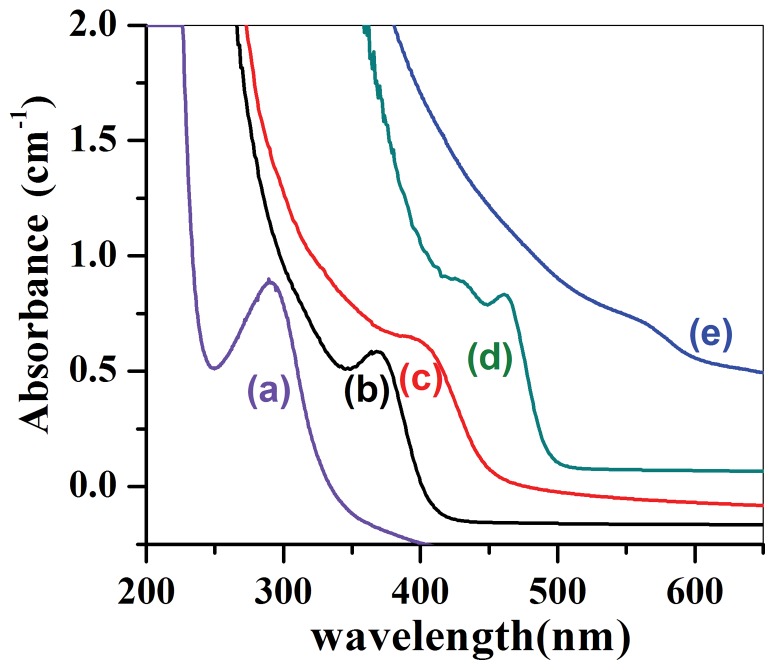
The UV absorption of CdSe1–xSx nanocrystals in different Se/S ratio, (a) x = 1, (b) x = 0.75, (c) x = 0.5, (d) x = 0.25 and (e) x = 0.